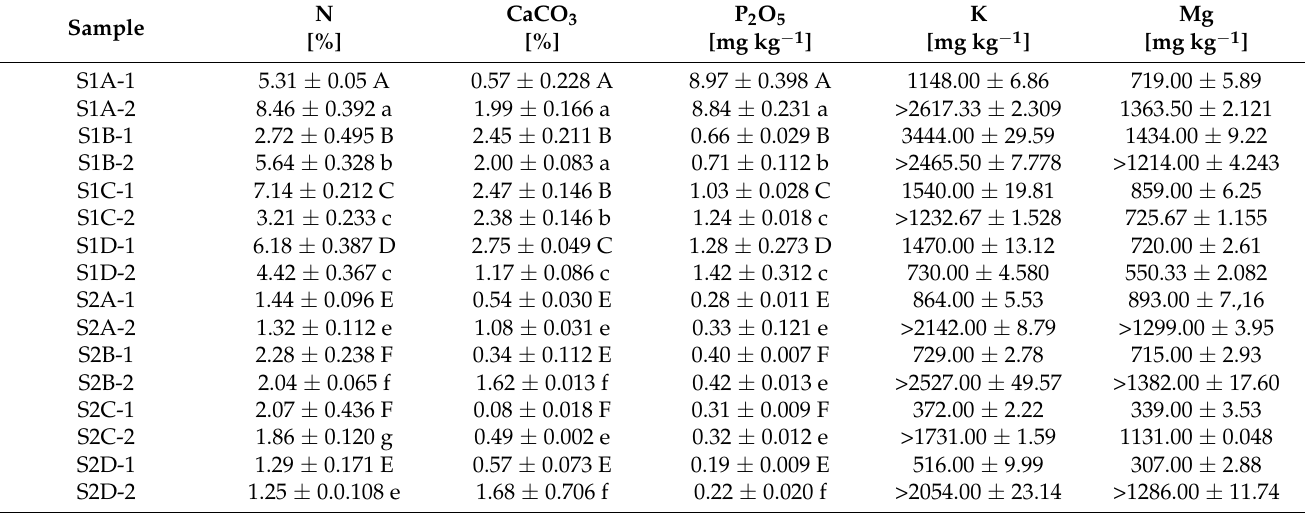
Table 3. Chemical composition of the studied soils. S1: soil from the limestone open-cast mining remediated with embankment; S2: soil from the lignite open-cast mining remediated with sewage sludge; subsequent letters A–D mean different remediated areas located at the same mine site; subse- quent numbers mean different sampling periods; 1: spring 2021, 2: spring 2022. Mean values ±